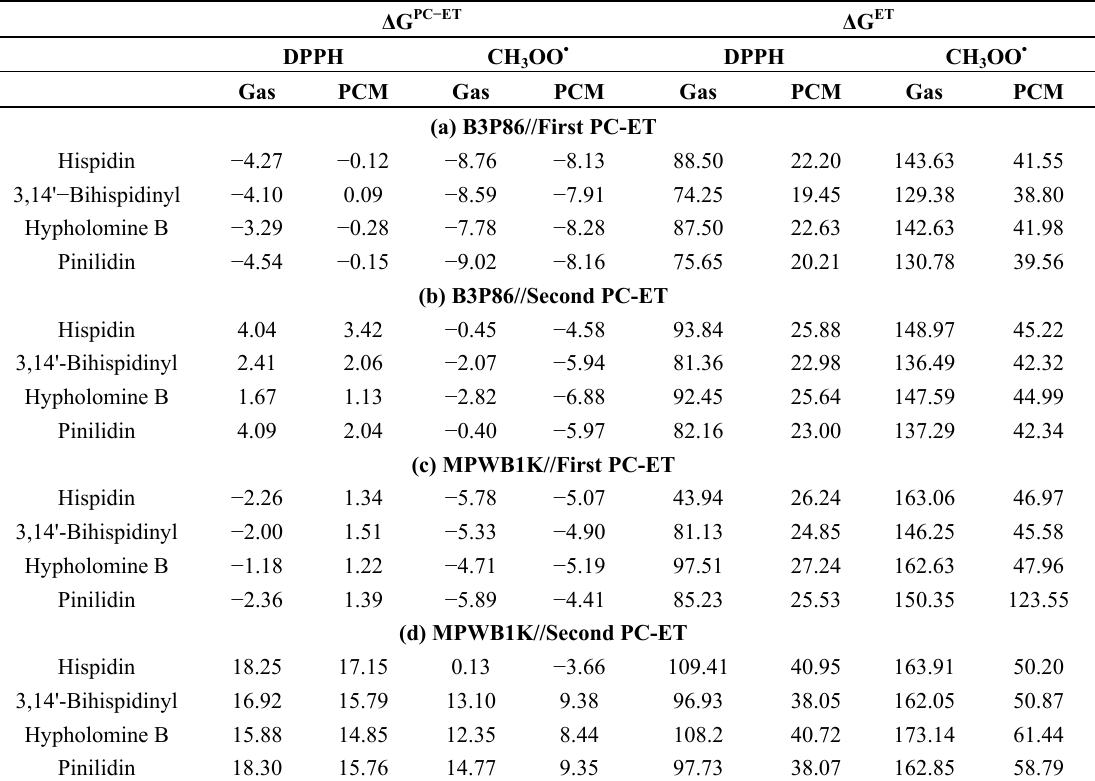
Table 4. Thermodynamics ( Δ G PC − ET and Δ G ET in kcal/mol) of the DPPH and CH radical scavenging by styrylpyrone